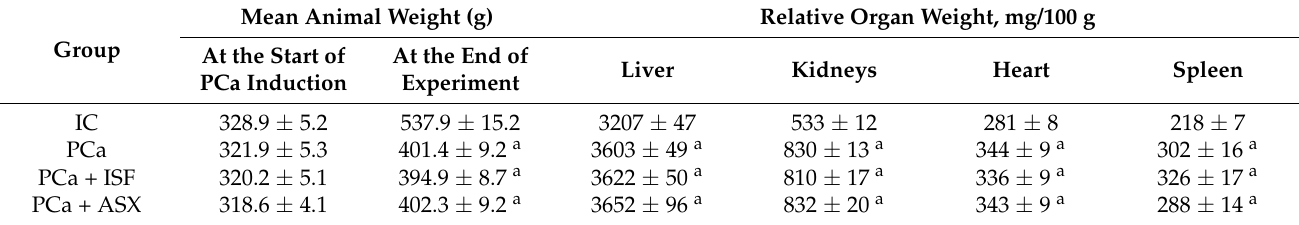
Table 1. Body weight and organ/body weight ratio of rats.